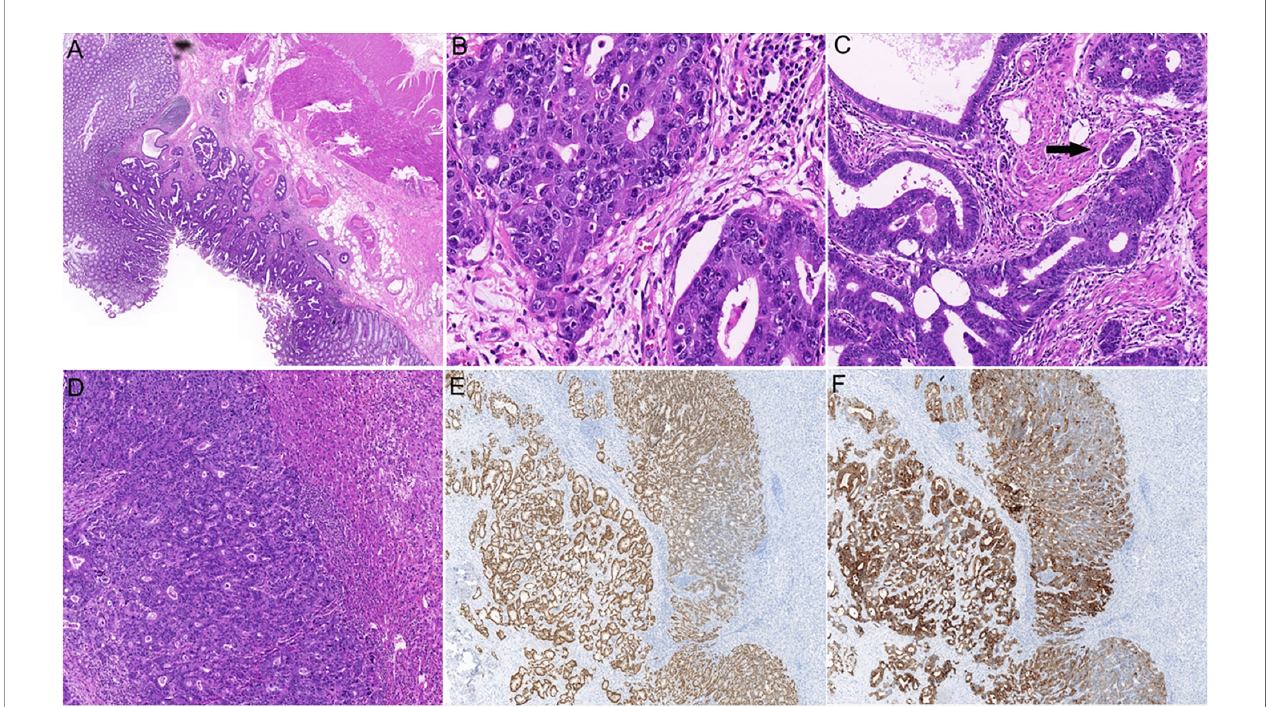
FIGURE 1 | Histopathological examination of the primary and metastatic tumors. (A) Hematoxylin and eosin (H&E) staining of colonic primary tumor shows glandular differentiation and invasion into the submucosa (×20). (B) High-power view shows the malignant epithelial cells arranging in a glandular or cribriform manner (×400). (C) The lymphovascular invasion of colonic adenocarcinoma is indicated by an arrow (×200). (D) H&E staining shows intrahepatic adenocarcinoma (×100). Immunostaining for CK20 (E) , ×50 and CDX2 (F) , ×50 con fi rmed the tumor originated in